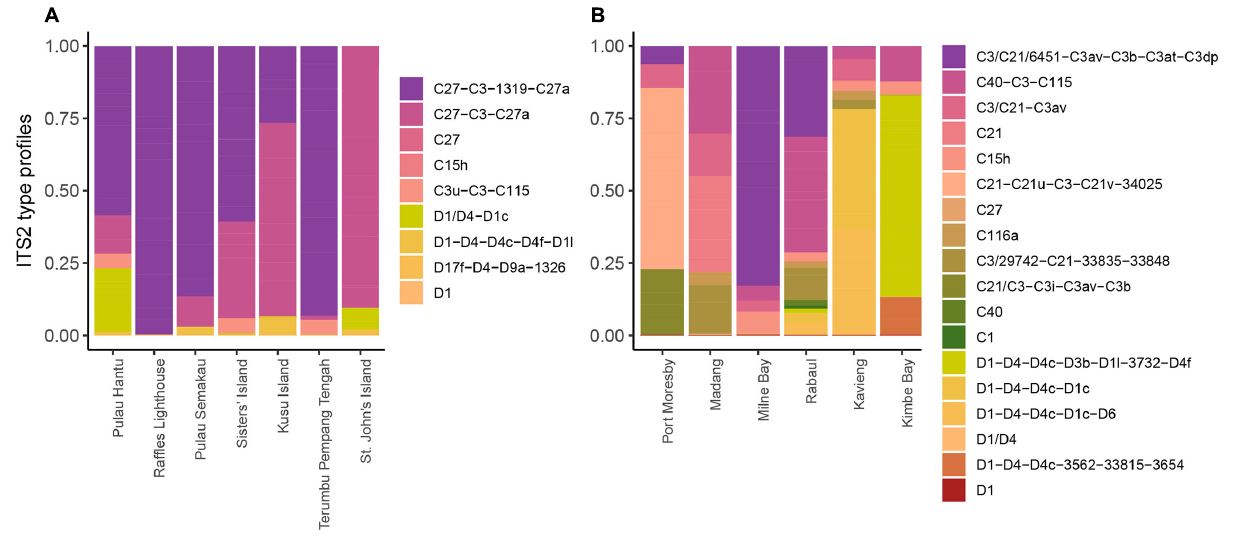
from Singapore and Papua New Guinea. Cladocopium